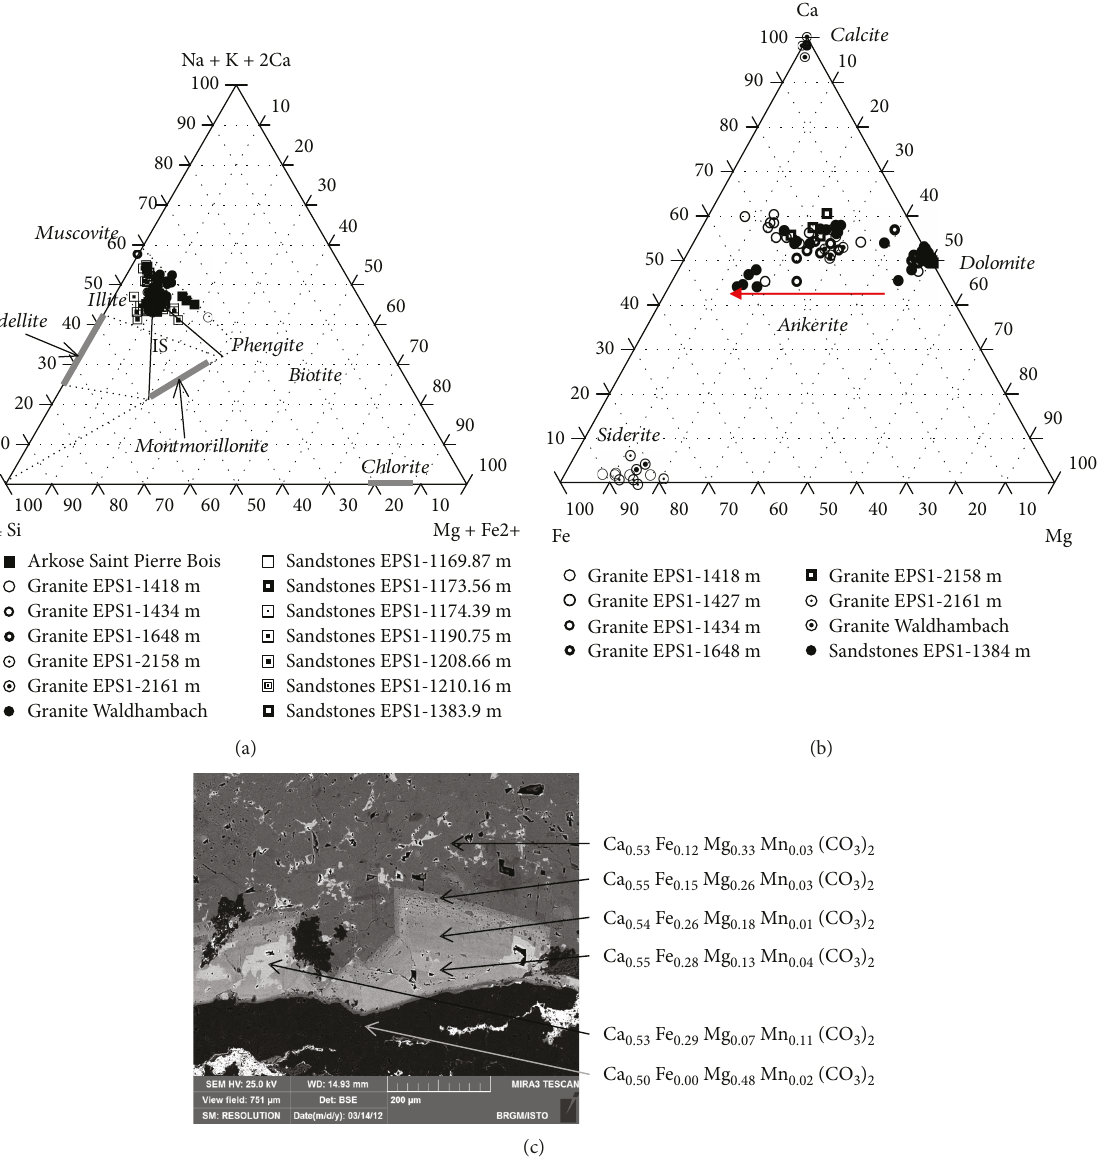
Figure 12: (a) Triangular 4 Si-(Na +K+ 2Ca)-(Mg+Fe 2+ ) diagram of Meunier and Velde [94] showing the nature of the illite-like clays present in fractures of granites (EPS1 and Walhambach) and in sandstones. (b) Triangular Fe-Ca-Mg diagram showing chemical compositions of the various generations of carbonates in fractures of granites (EPS1 and Waldhambach) and in EPS1 sandstones. (c) Backscattered electron image showing chemical zoning of the dolomite-ankerite-kutnahorite solid solution